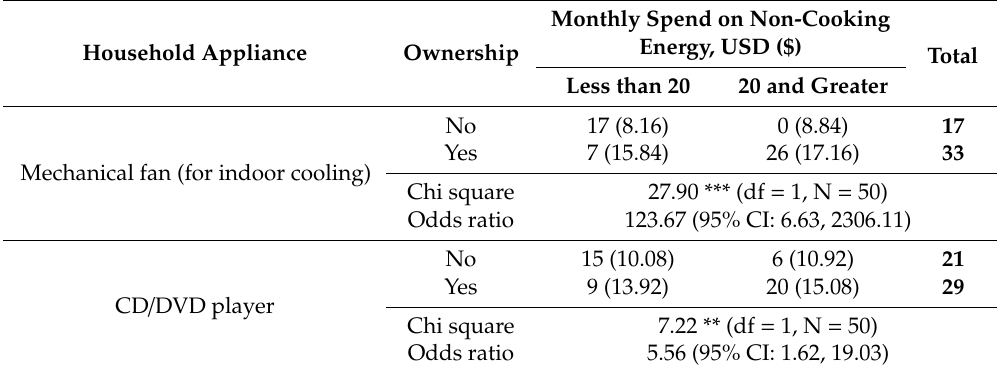
Table 6. Association between the ownership of household appliances and the monthly spend on non-cooking energy, Lagos State.